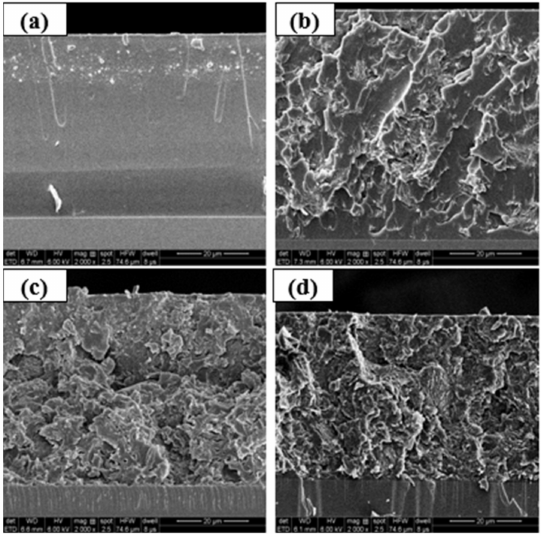
Figure 2. Cross-section SEM images of EP coatings with different rGO doping concentrations: